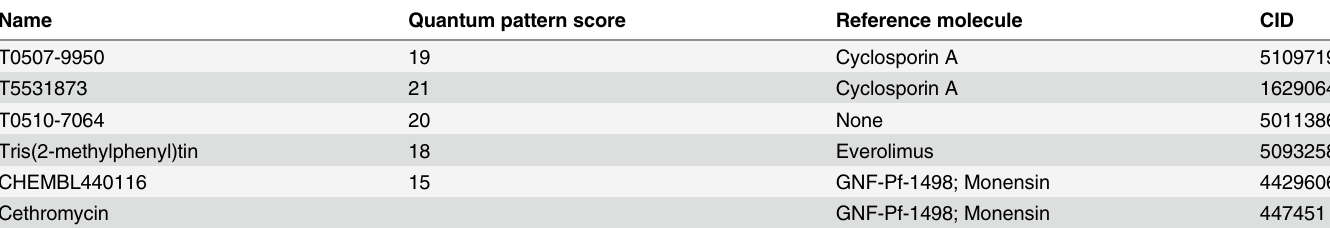
Table 3. Summary of quantum scores with molecule identifications and reference molecules for